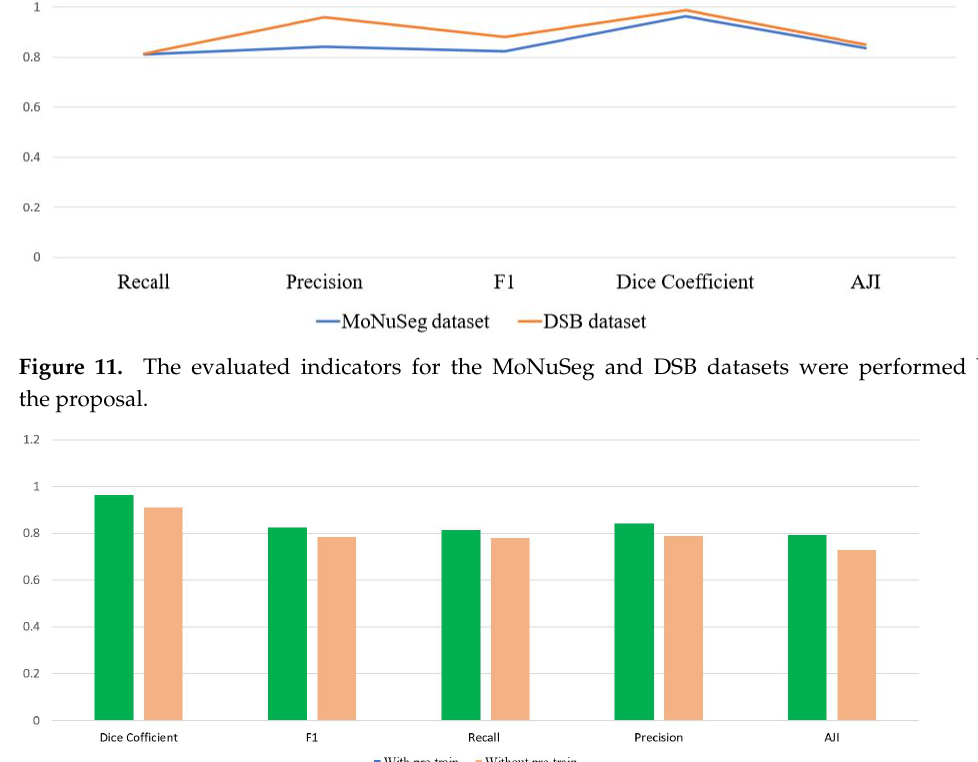
Figure 12. The performance comparison of the CBA model with and without the pre-trained model in the MoNuSeg dataset.